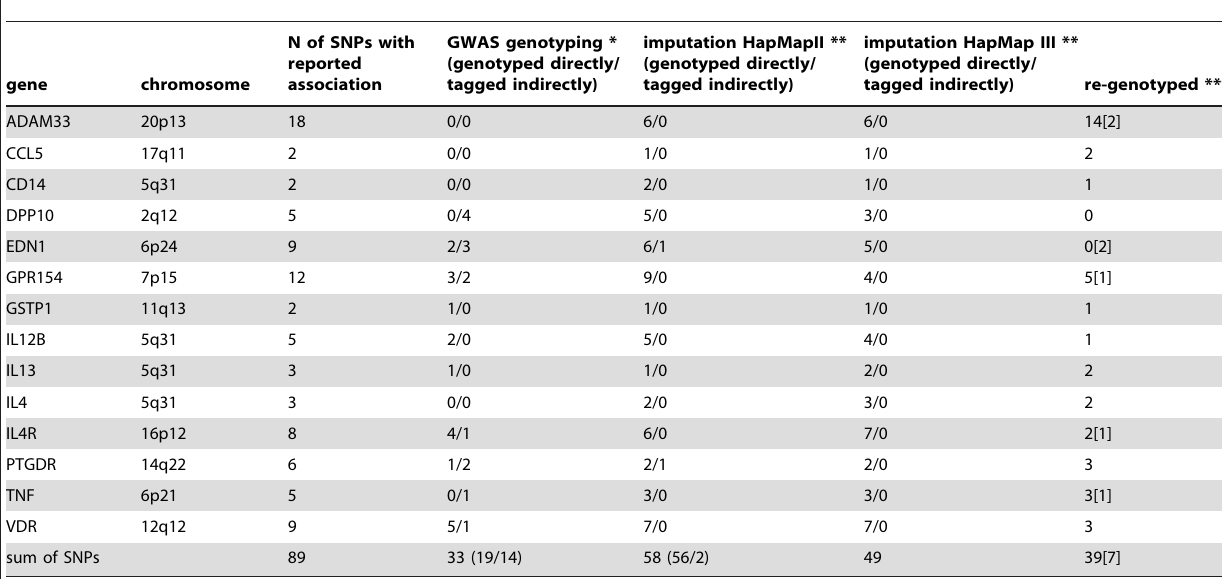
*on Illumina Sentrix HumanHap300 BeadChip. **based on Illumina Sentrix HumanHap300 BeadChip and Hapmap phase II or III respectively. ***by MALDI-TOF or TAQMAN. [ ] indicates SNPs for which genotyping failed.